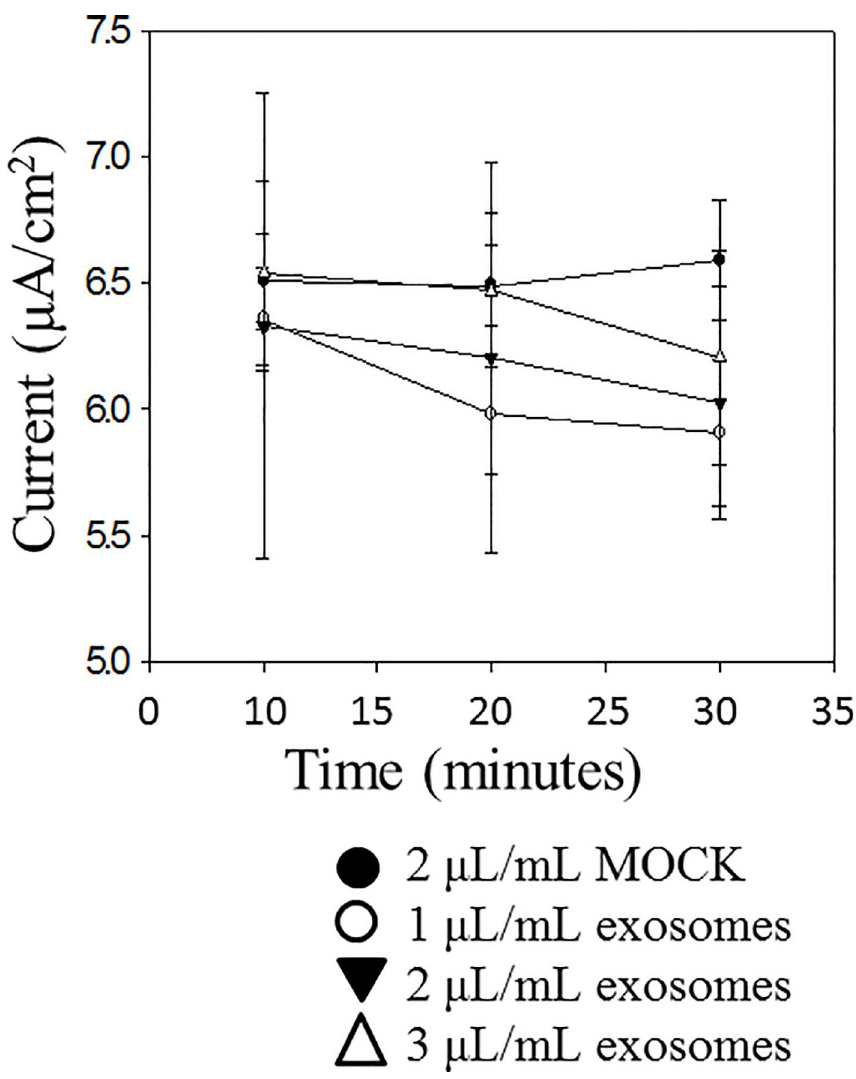
Fig 7. Effect of exogenous application of basolateral exosomes from LLC-PK1 cells on amiloride- sensitive transepithelial current measurement in mpkCCD cells. Cells were cultured for 10 days to allow the formation of tight junctionsand the measurement of resistancesand voltages across confluent monolayers. Exosomes isolated from conditioned media present on the basolateral side of LLC-PK1 cells cultured on permeabletranswell inserts were appliedto the apical side of mpkCCD cell monolayers. Application of these exosomes resulted only in a modest decrease in transepithelial current over time. Each point representsthe mean ± s.e. from 3 separate inserts containingcells (N =